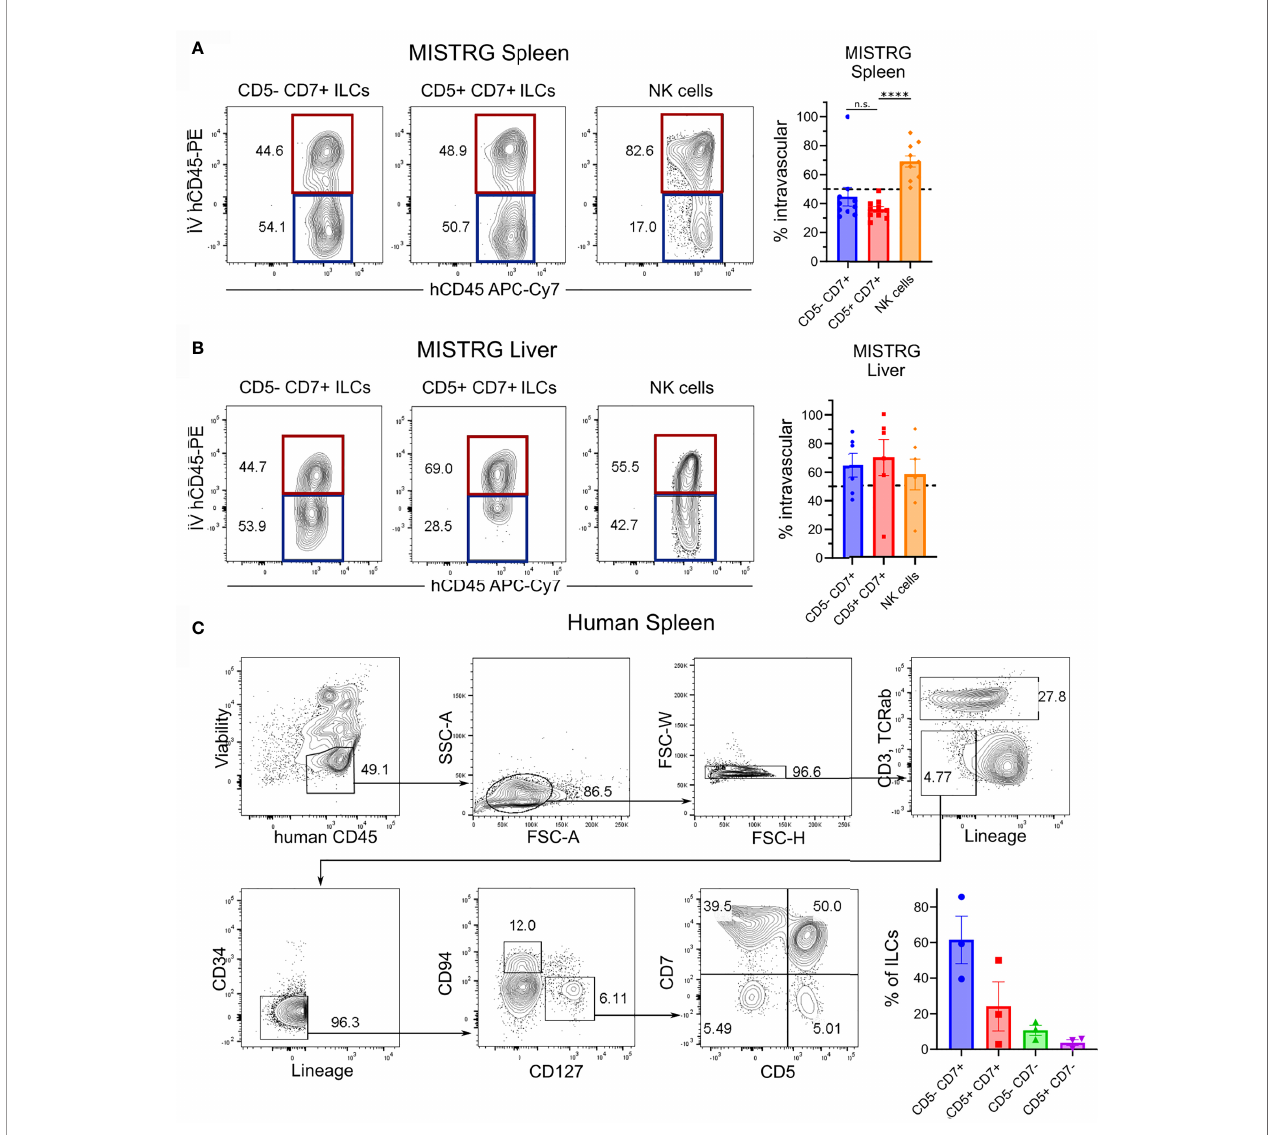
FIGURE 7 | Human CD5 + CD7 + ILCs reside in the spleen and liver. (A, B) Flow cytometry analysis of intravascular (red) and extravascular (blue) CD5 - CD7 + ILCs, CD5 + CD7 + ILCs, and NK cells in the spleen (A) and liver (B) of HSPC-engrafted MISTRG mice. Frequencies of intravascular (IV-hCD45-PE + ) spleen and liver ILC subsets and NK cells (n = 6-10) are shown on the right. n.s., not signi fi cant; **** P < 0.0001 by one-way ANOVA, Tukey ’ s post-test. (C) Frequencies of CD5 - CD7 + and CD5 + CD7 + ILCs in human spleen (n = 3). ILCs were gated as shown as viable human CD45 + CD3 - TCR ab - CD94 - CD127 + cells that were negative for lineage markers (CD11c, CD14, CD19, CD123, FceRI) and CD34. Data represent mean ± SEM and are representative of three independent